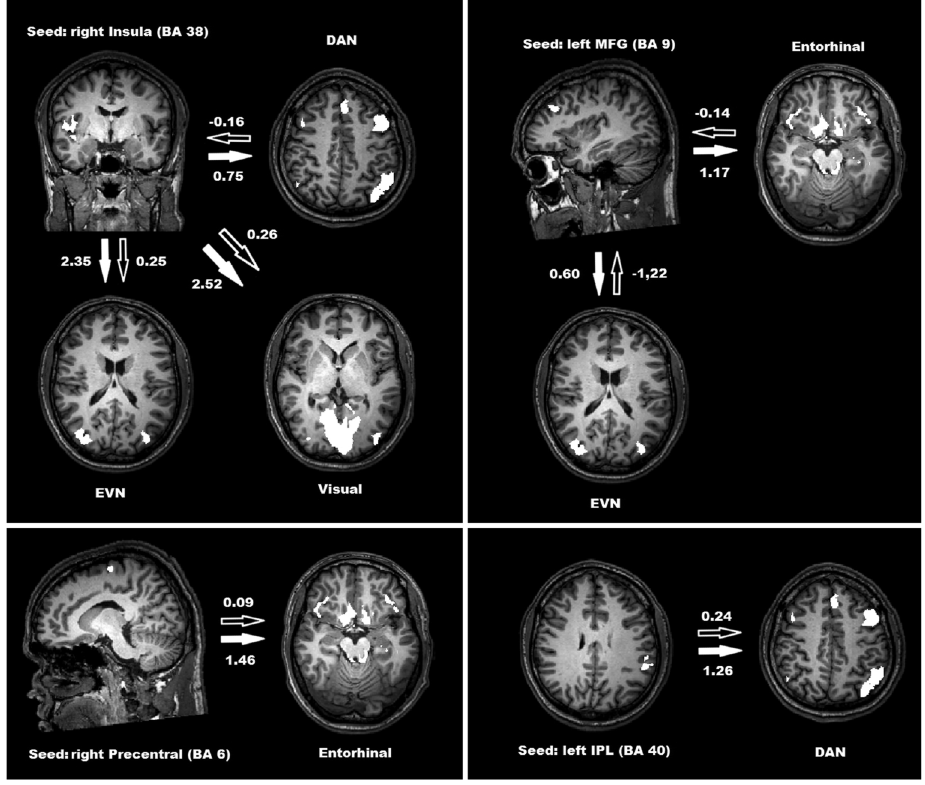
Figure 3. Significant Granger causality mapping (GCM) values from seed volume-of-interest to resting-state networks (P , 0.05, Student t -test). Black arrows show GCM values in standard acquisition and white arrows show GCM values in silent echo-planar imaging acquisition. DAN = dorsal attention network; EVN = extrastriate visual network; MFG = middle frontal gyrus; Entorhinal = entorhinal network; IPL = inferior parietal lobule; BA = Brodmann